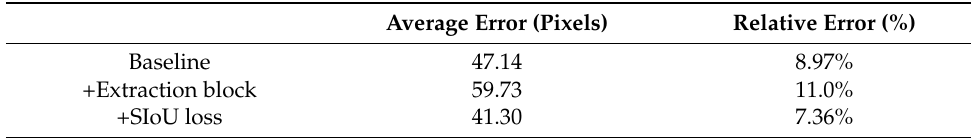
Table 8. Result of ablation experiments in the complete